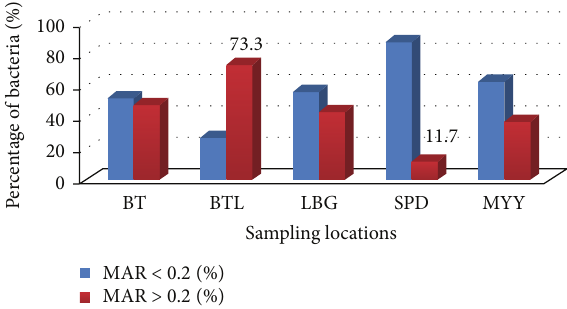
Figure1:MARindexanalysisbasedonsamplinglocations;BT:Batu Tujuh (Seven Miles), BTL: Bintulu, LBG: Limbang, SPD: Sampadi, and MYY: